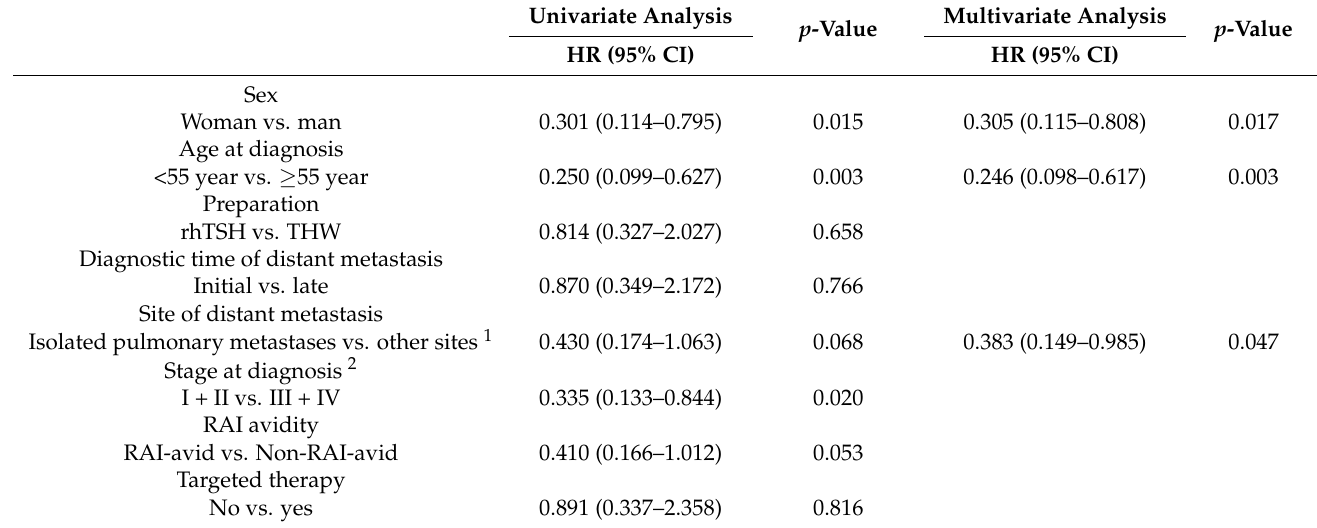
Table 3. Univariate and multivariate analyses of risk factors for disease-specific survival. Univariate Analysis Multivariate Analysis p -Value p